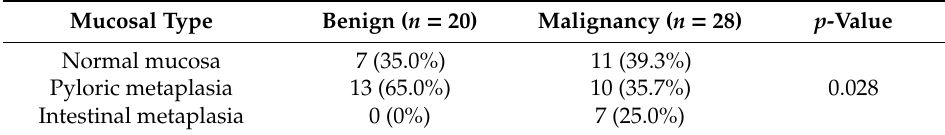
Table 4. Di ff erences between the types of background mucosa surrounding carcinomas.